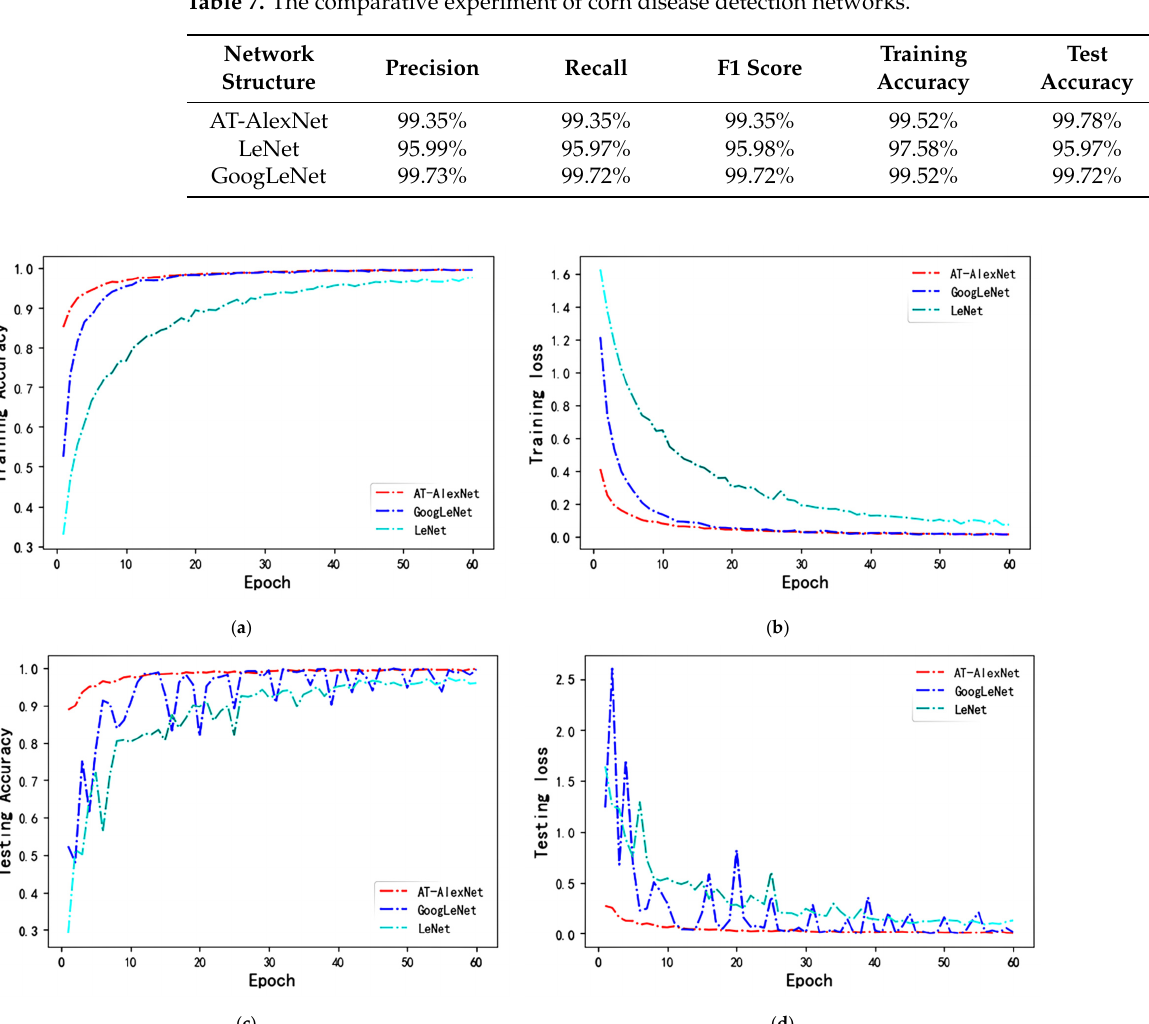
Table 6. The recognition accuracy of the model.